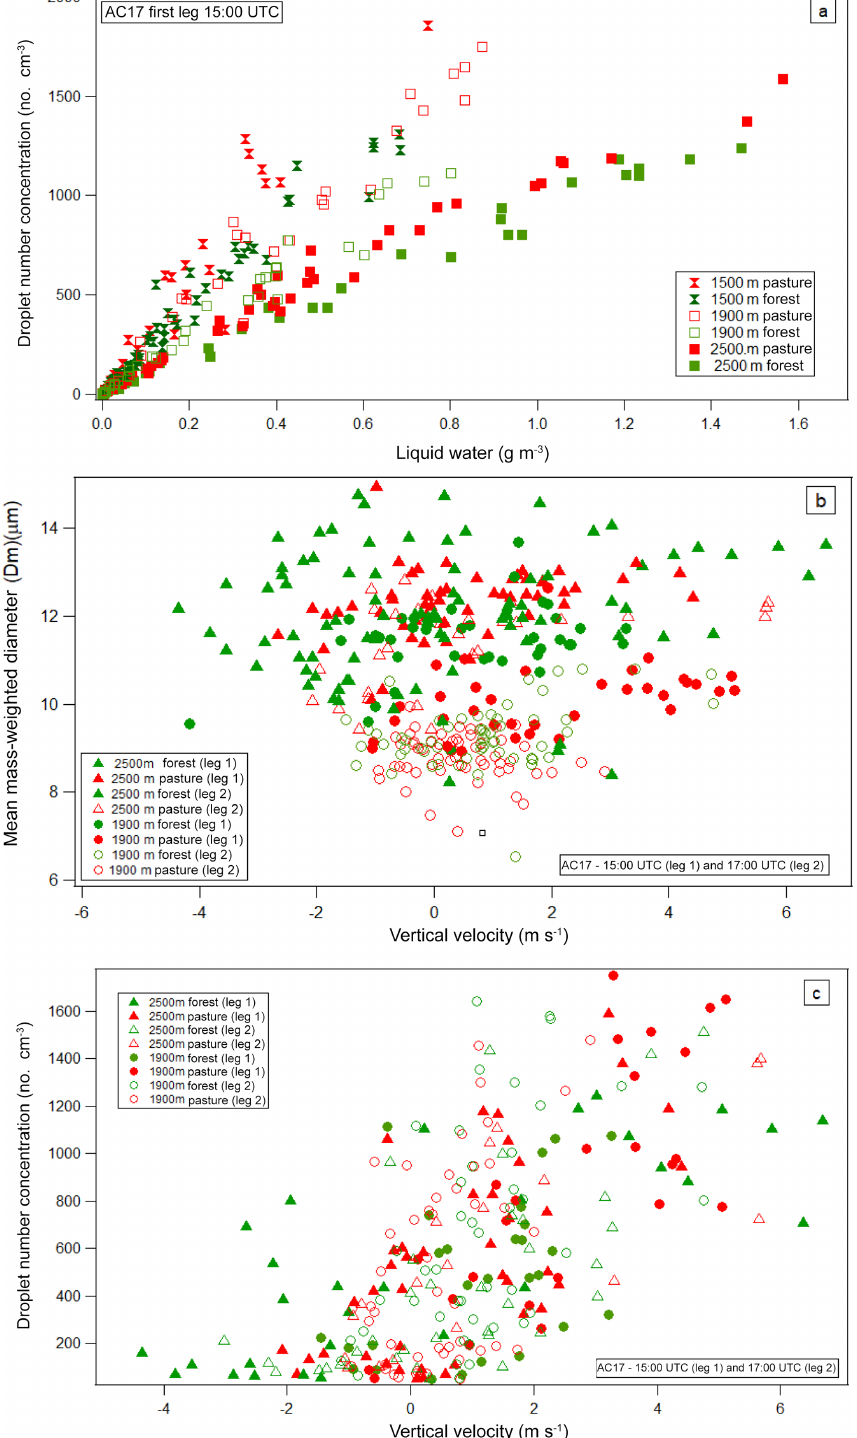
Figure 11. (a) Cloud droplet concentration as a function of liquid water content; (b) mass-weighted mean cloud diameter as a function of vertical velocity; and (c) cloud droplet concentration as a function of vertical velocity for forest and pasture at different